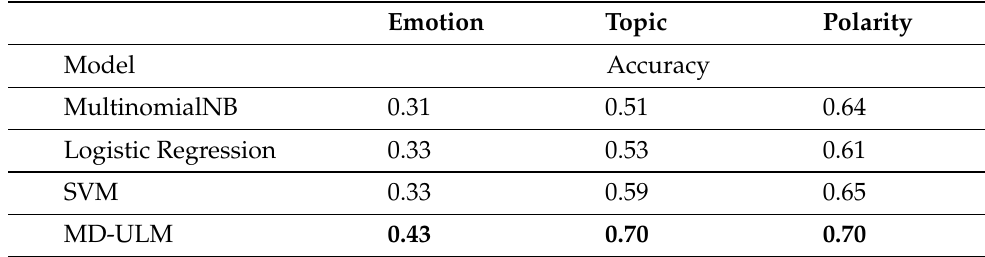
Table 1. Performance results for Emotion, Topic and Polarity